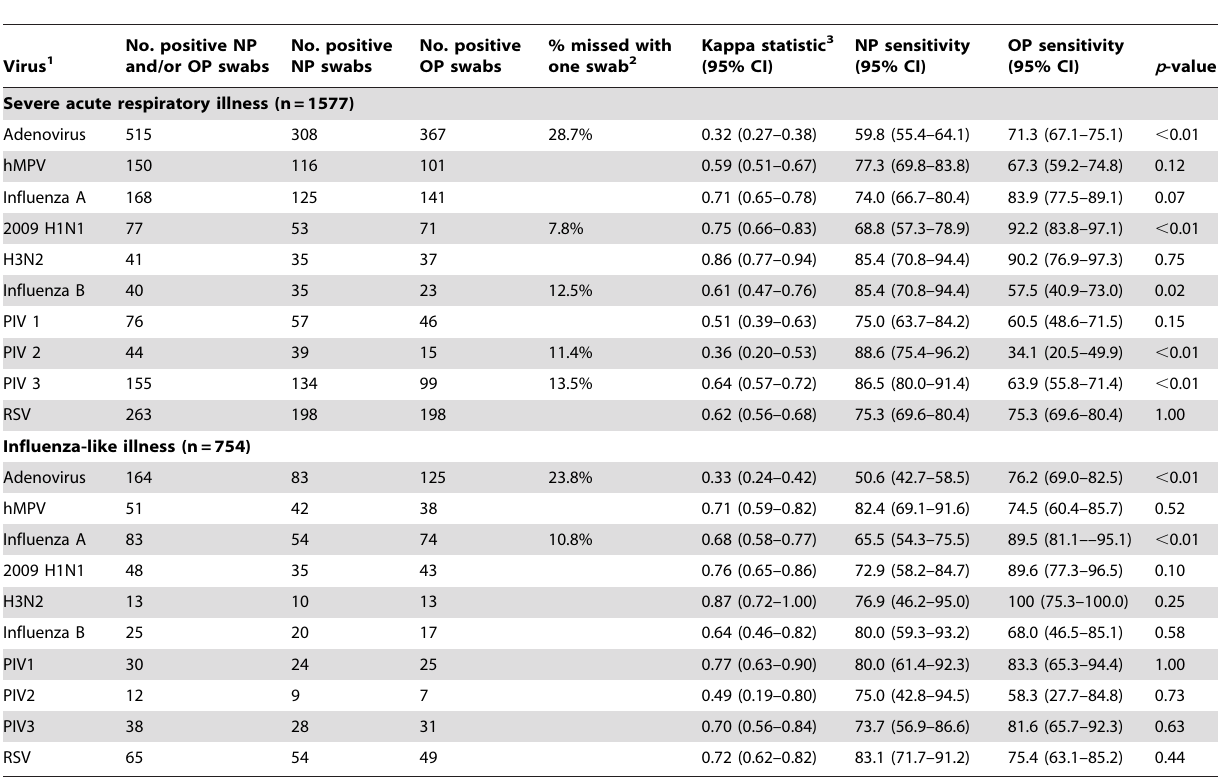
Table 5. Kappa and sensitivity values of paired nasopharyngeal (NP) swabs and oropharyngeal (OP) swabs for respiratory viruses by illness category – Kenya,